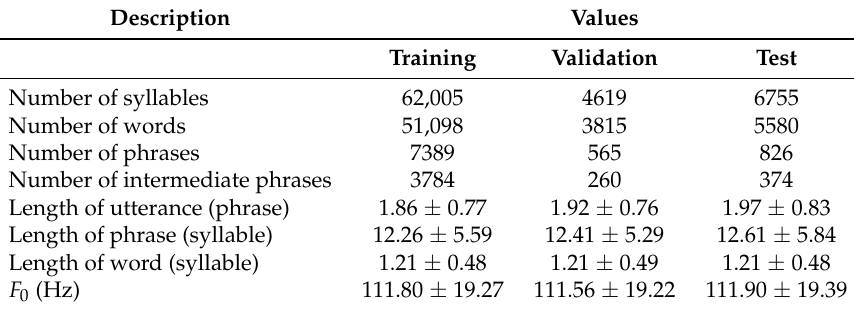
Table 2. Statistical information of training, validation, and test sets.